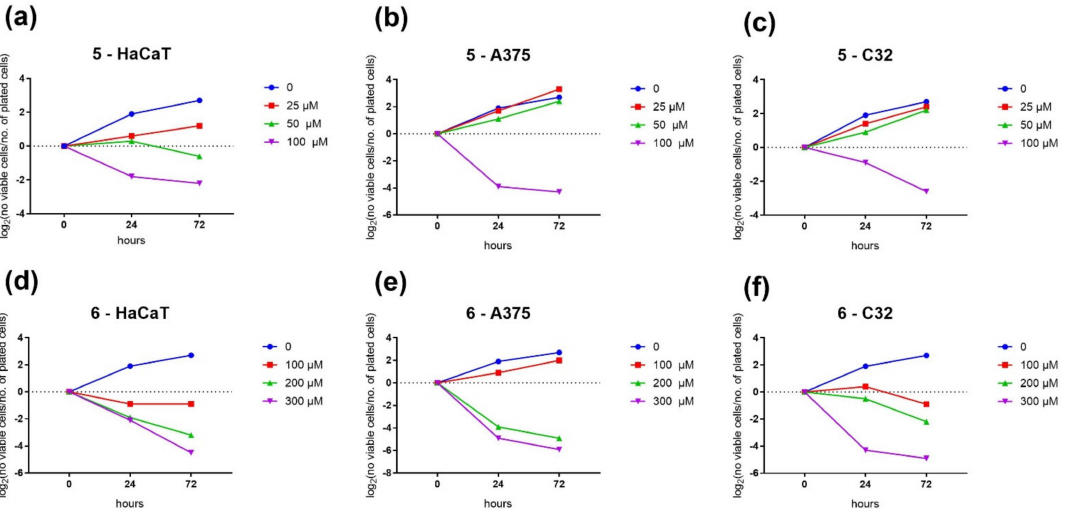
Figure 5. The population doubling time test was performed on human keratinocytes HaCaT ( a , d ), a melanotic melanoma cell line (A375) ( b , e ) and an amelanotic melanoma cell line (C32) ( c , f ) that were incubated at a density of 300 × 10 3 /well. Cells were exposed to compounds for 24 h and 72 h at three different concentrations, 25, 50 and 100 µ M for compound 5 , and 100, 200 and 300 µ M for compound 6 . Control cells were maintained in a growth medium with 10% fetal bovine serum (FBS) without treatment by any compounds. The number of cells was determined by counting using KOVA Slide. The results are presented as a log2 (no. of viable cells/no. of plated cells), performed three